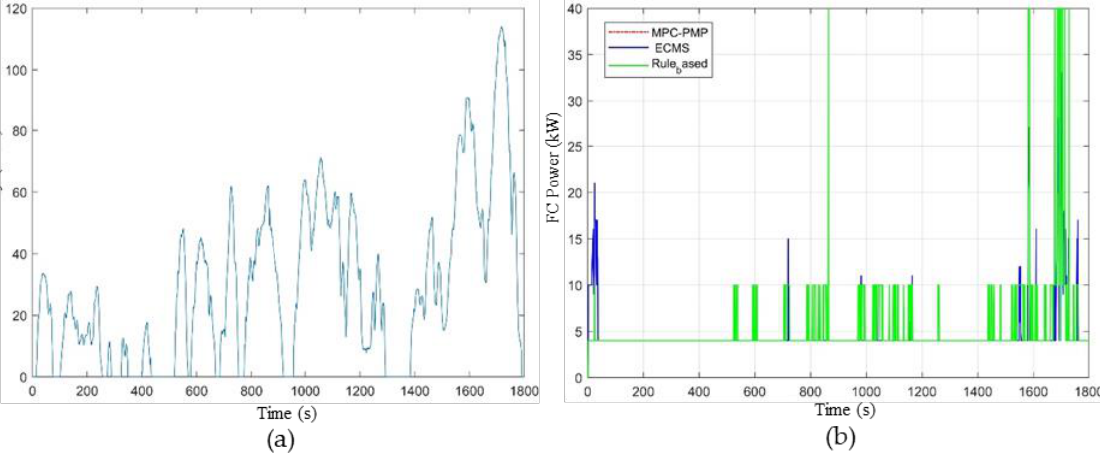
Figure 11. Optimized results under CLTC conditions: ( a ) CLTC test conditions; ( b ) optimized power waveform under three algorithms.